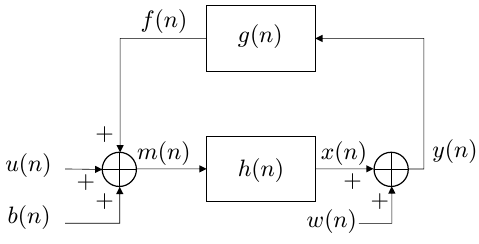
Figure 1. In-room speech reinforcement